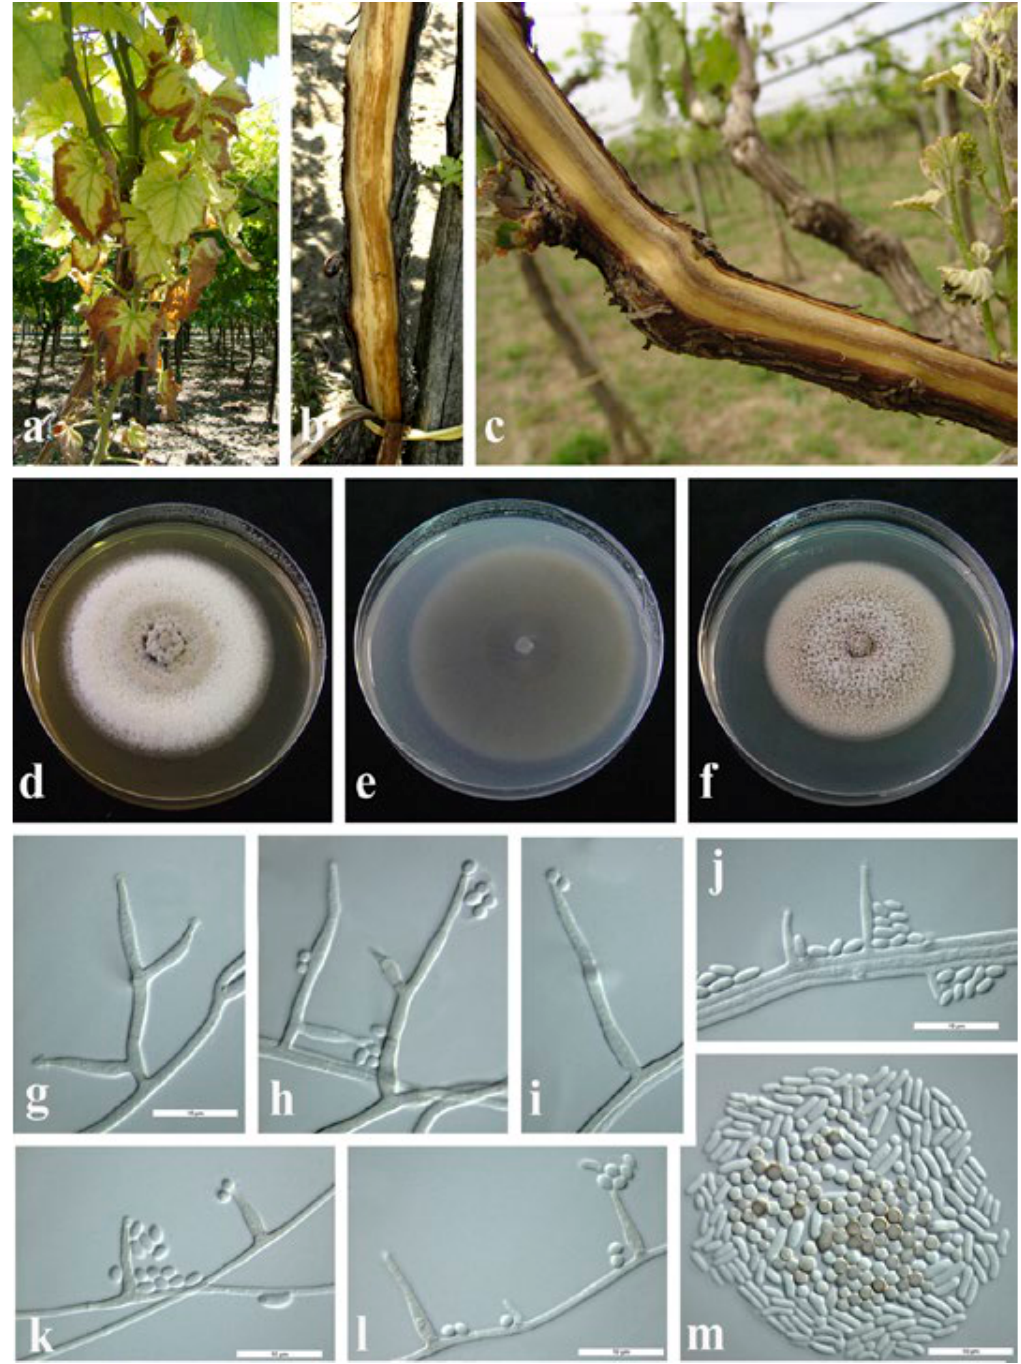
Figure 1. (a‒c) Disease symptoms observed on the grapevine plants. (a) Foliar symptoms of discoloration and marginal necrosis. (b, c) Sub-cortical brown streaking on trunk and young cordons. (d–f) Twenty-one-day-old colonies on MEA (d), OA (e) and PDA (f) at 25°C. (g) Branched conidiophores. (h, i) Single conidiophores. (j) Mycelia occurring in bundles of up to three, with type I and type II phialides. (k, l) Type II phialides. (m) Brown, sub-globose, and hyaline, allantoid and oblong-ellipsoidal